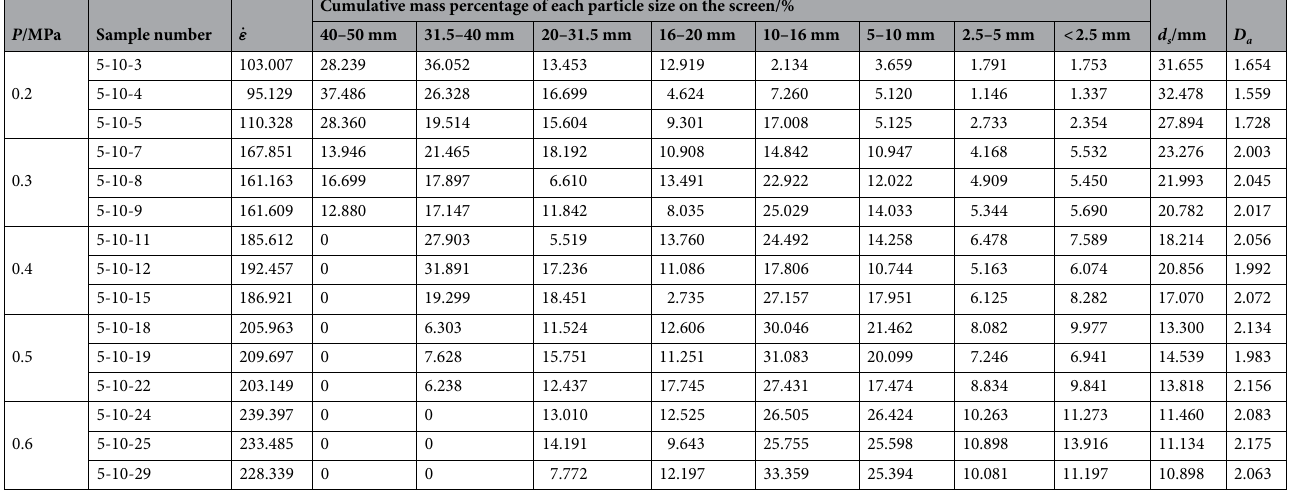
Table 4. Fragmentation screening and fractal